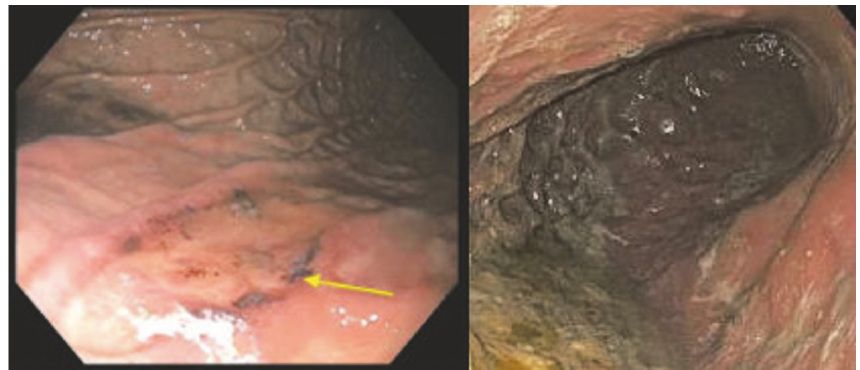
Figure 1: (a) EGD at admission. Nonbleeding ulcer located in the gastric body. There is black mucosal discoloration present. Biopsies were taken. (b) Gastric body during repeated EGD 6 months later. Significant residue in the stomach. Ulceration not visualized. EGD: esophagogastroduodenoscopy.